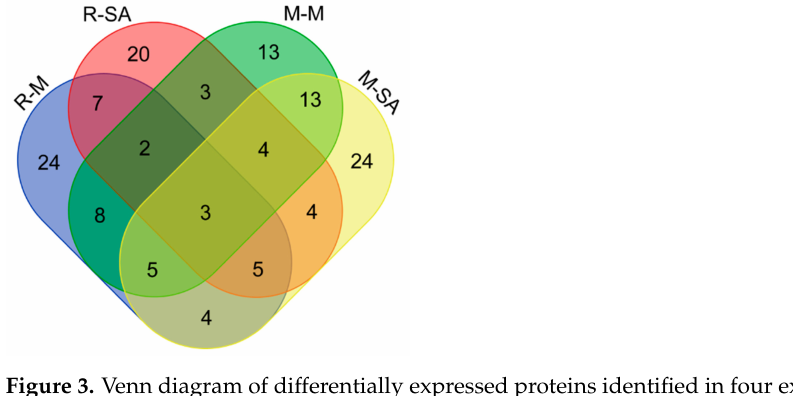
Figure 3. Venn diagram of differentially expressed proteins identified in four experimental groups. Different color schemes denote different group sets, that is, Minghui added with SA (M-SA), Minghui inoculated with M. grisea (M-M), Nipponbare added with SA (R-SA), and Nipponbare inoculated with M. grisea